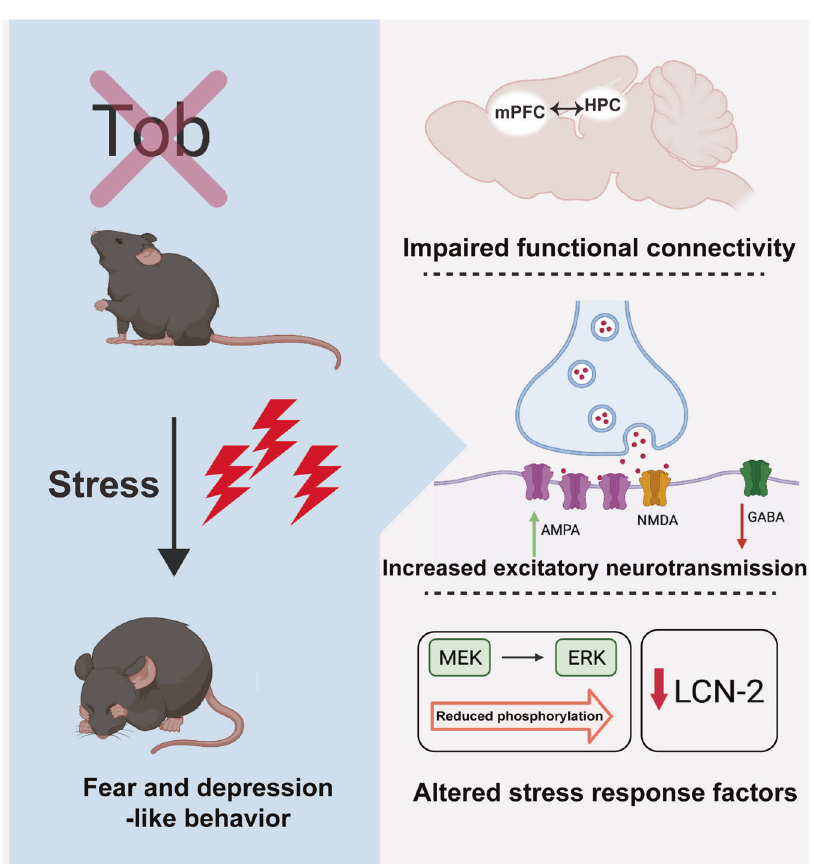
Fig. 6 Summary showing the role of TOB in hippocampus-mediated stress response. Tob deletion in mice induces hippocampal-dependent pathological behaviors of increased fear and depression-like behaviors. This can be explained by the altered functional connectivity between stress-related regions like hippocampus (HPC) and medial prefrontal cortex (mPFC). Tob -de fi cient hippocampal neurons showed increased excitatory and decreased inhibitory neurotransmission. Stress-induced ERK phosphorylation and LCN-2 expression were lower in the hippocampus of Tob -KO